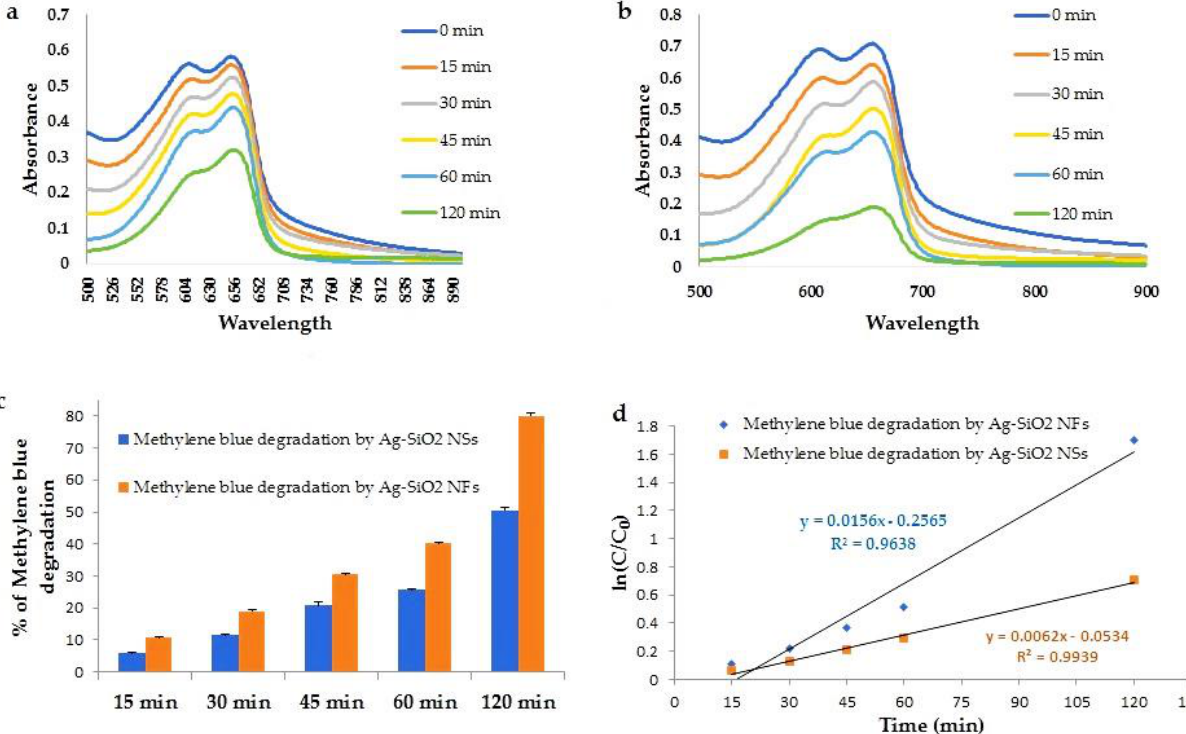
Figure 11. Absorbance spectra of methylene blue with time after exposure to Ag-SiO 2 NSs ( a ) and Ag-SiO 2 NFs ( b ). Degradation percentage of methylene blue after treatment with Ag-SiO 2 particles ( c ). First-order kinetic plot of ln(C 0 /C) versus time for the degradation of methylene blue ( d ).